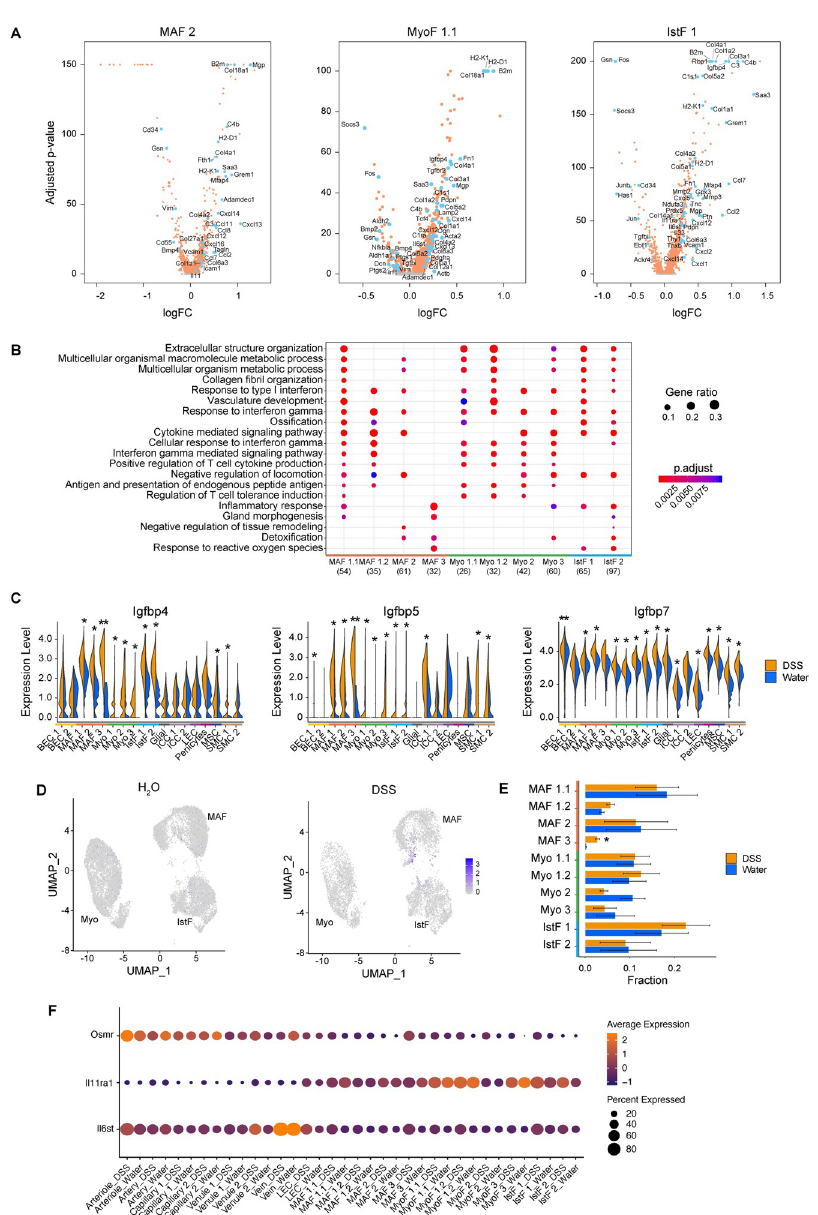
Fig 4. Intestinal inflammation elicits a dynamic fibroblast response. (A) Volcano plots depicting DEGs between water- and DSS-treated samples for select fibroblast clusters. Each dot represents an individual gene, and dot colors represent the contributing fibroblast subset when that gene is differentially expressed. Significant DEGs had FDR < 0.05 using MAST (see Methods). (B) GO enrichment of DEGs for each fibroblast cluster comparing water- and DSS- treated mice. Color represents adjusted p -value of GO enrichment annotation for each fibroblast cluster; diameter represents gene ratio for each fibroblast cluster. (C) Violin plots of expression levels of select IGFBP family members across all stromal clusters in water- and DSS-treated samples. Normalized gene expression levels are plotted on the y- axis. Significant DEGs had FDR < 0.05, and respective adjusted p -values derived using MAST (see Methods); � p < 0.05, �� p < 0.001. (D) Fibroblast frequency changes between water- and DSS-treated samples. Significant frequency changes derived using Dirichlet multinomial regression; � p < 0.05. (E) Feature plot for IL11 expression in fibroblasts from water- and DSS- treated samples; � p < 0.05 (F) Expression of select IL6 family receptors across fibroblast clusters in water- and DSS-treated samples. Color represents average expression of marker gene within clusters; diameter represents percentage expression of marker gene within clusters. DEG, differentially expressed gene; DSS, dextran sulfate sodium; FDR, false discovery rate; GO, gene ontology; IGFBP, insulin growth factor binding protein; IstF, interstitial fibroblast; MAF, mucosa-associated fibroblast; MyoF, myofibroblast.